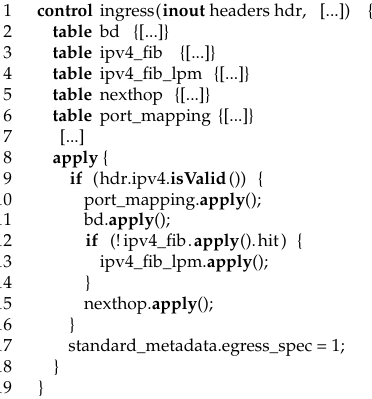
table bd {[...]} 3 table ipv4_fib {[...]} 4 table ipv4_fib_lpm {[...]} 5 table nexthop {[...]} 6 table port_mapping {[...]}